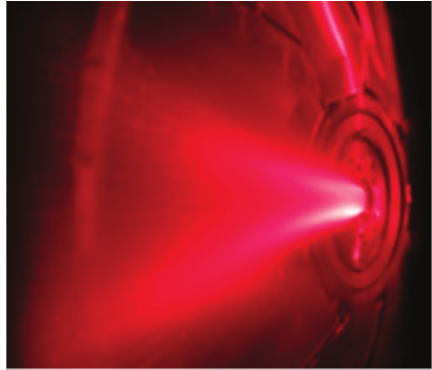
Figure 3: The fuel spray in a specifically built air box.